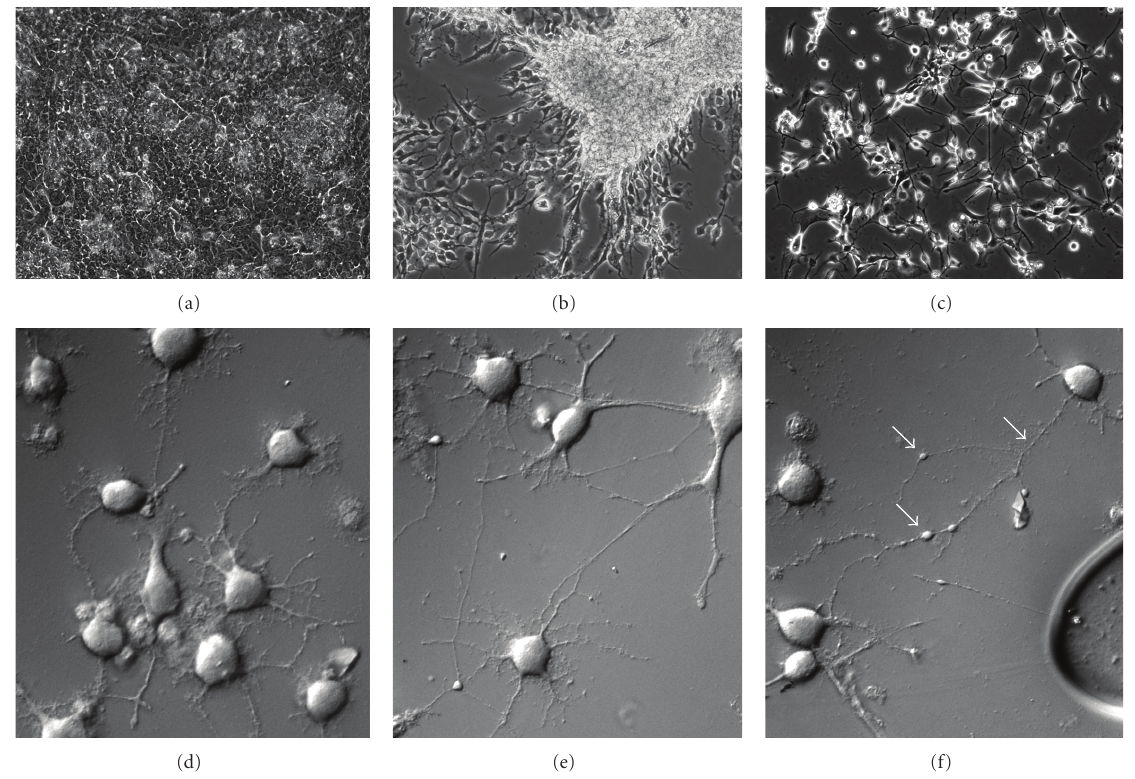
Figure 4: Derivation of neural progenitor cells (NPCs) from marmoset iPS cells and di ff erentiation of NPCs to mature neurons. The series (a)–(c) shows the transition from undi ff erentiated iPS cells (a), to a line of NPCs (b), to mature neurons (c) (100x phase-contrast images). NPCs placed on a polylysine/laminin-coated glass surface stop dividing and form extensive axons and dendrites. Details of this further maturation are shown in series (d)–(f) (400x di ff erential interference contrast images). Note particularly the varicosities of di ff erent sizes indicated by arrows in (f). These are sites of accumulation of cellular organelles and are precursors to the formation of synapses [37]. Their presence indicates the degree of maturity of these